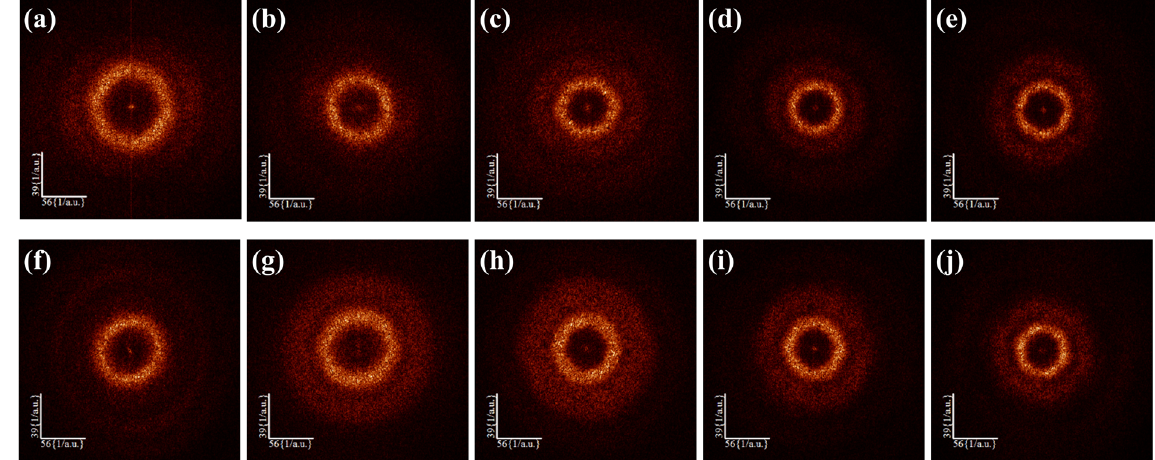
Figure 3. Fast Fourier transform images of TiO 2 nanotube arrays anodized at 60 V for 1 hour in ethylene glycol containing (a–e) 2, 4, 6, 8, 10 vol% distilled water with 0.2 wt% NH 4 F and (f–j) 2, 4, 6, 8, 10 vol% distilled water with 0.4 wt% NH 4